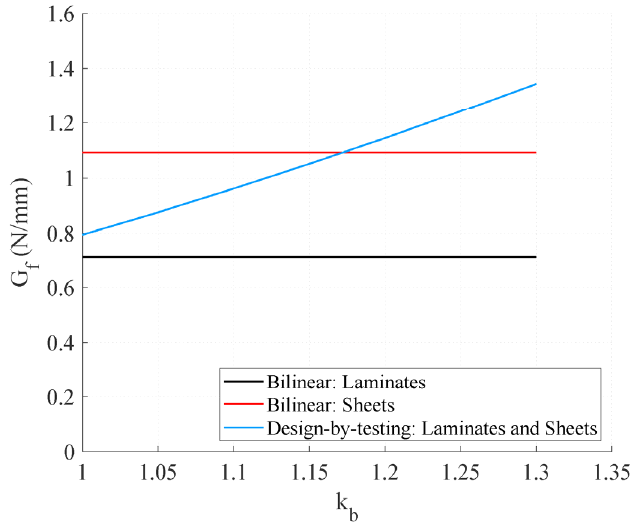
Figure 2. Fracture energy according to the suggested bond-slip approaches (values of f cm and f ctm equal to 44.76 MPa and 3.6 MPa, respectively).